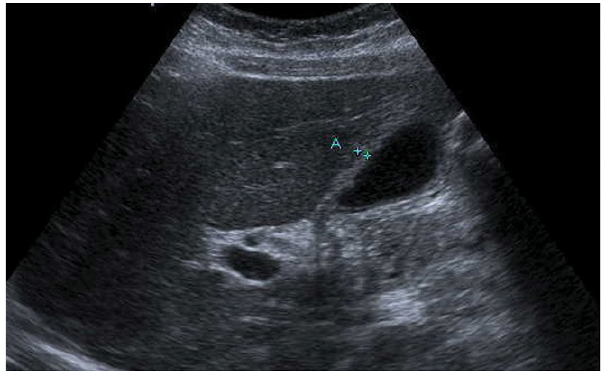
Figure 1 - Perihepatic and pericholecystic effusion.